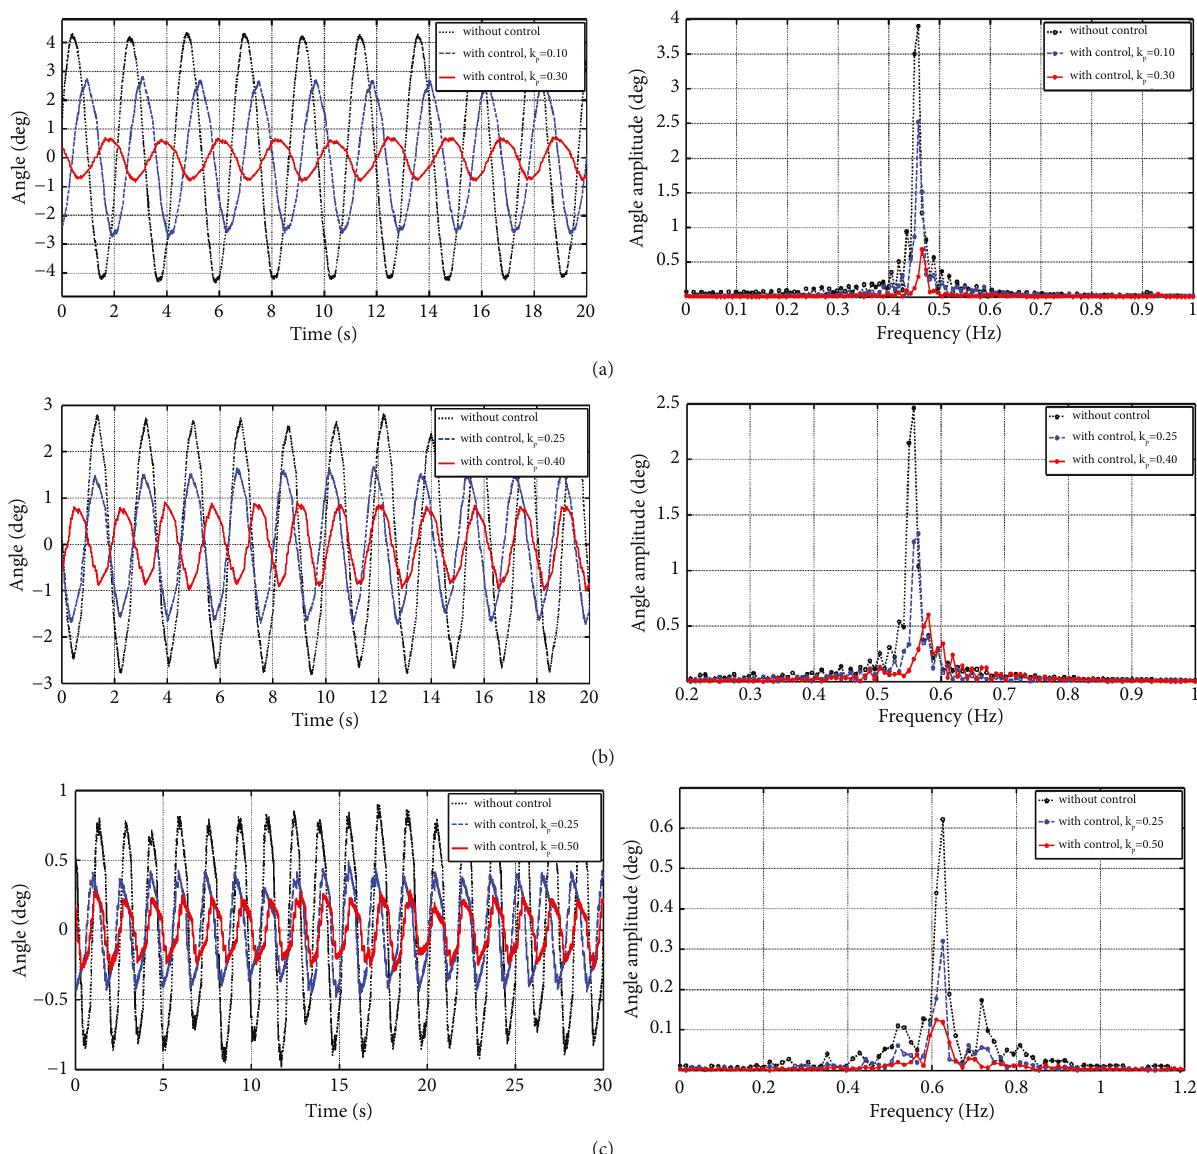
Figure 10: Vibration control Experiment II excitation at (a) 0.46, (b) 0.56, and (c)